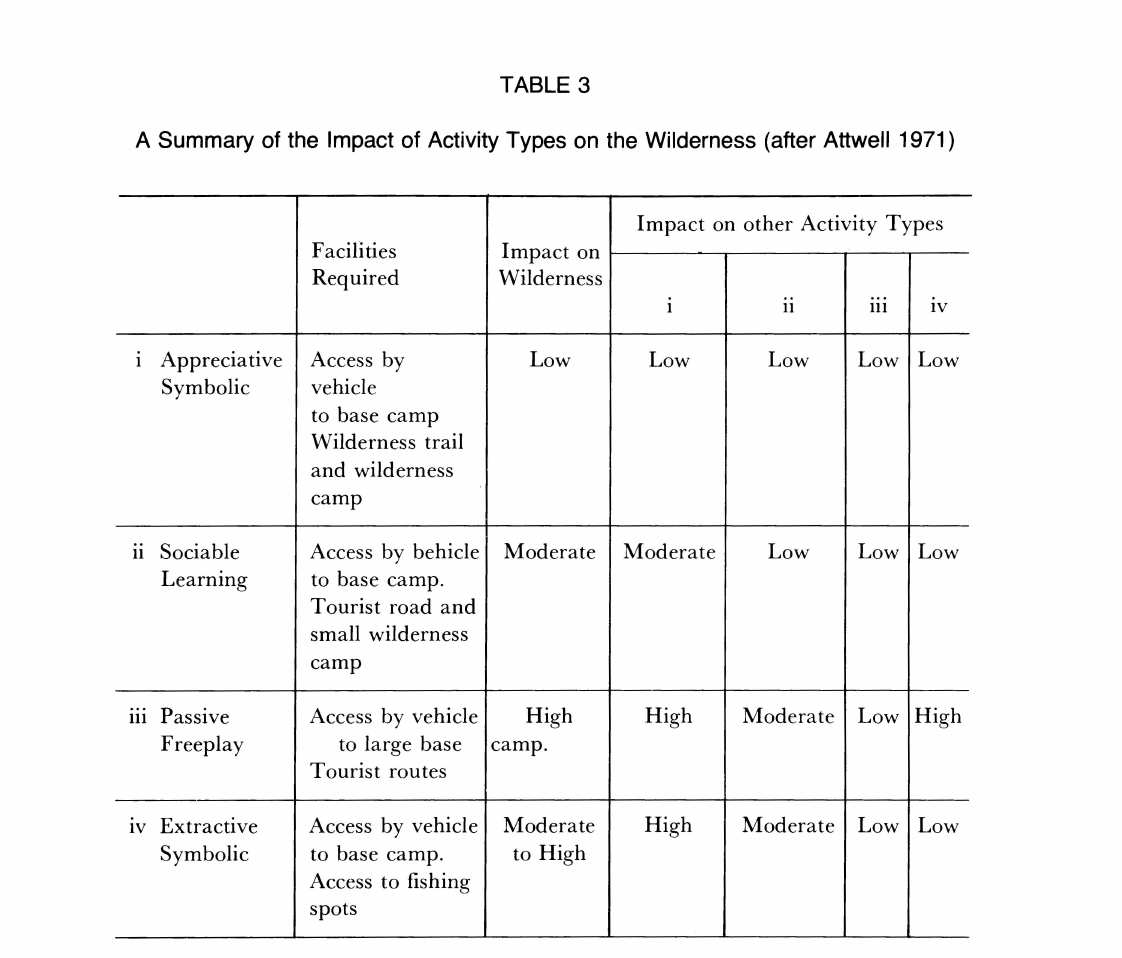
A Summary of the Impact of Activity Types on the Wilderness (after Attwell 1971)